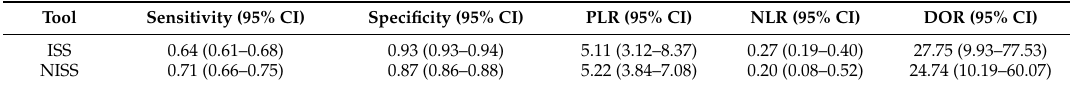
Table 3. Pooled estimates of the Injury Severity Score and New Injury Severity Score.